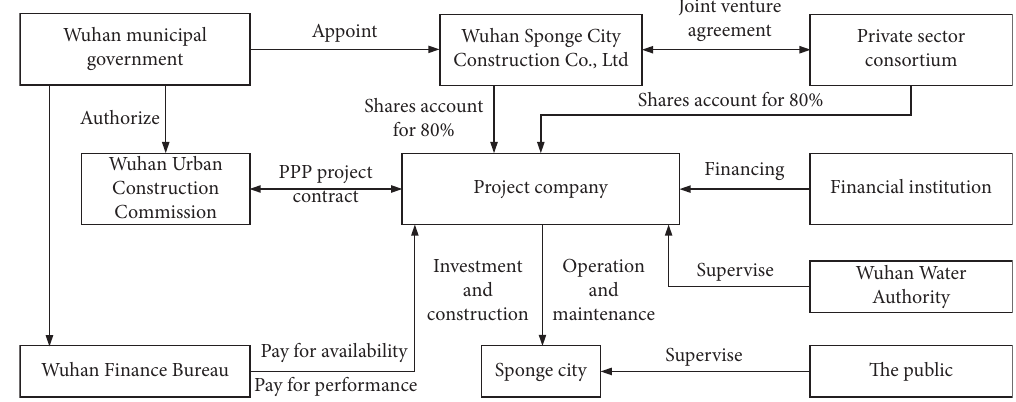
Figure 4: The specific operation mode of the case. Table 4: Risk